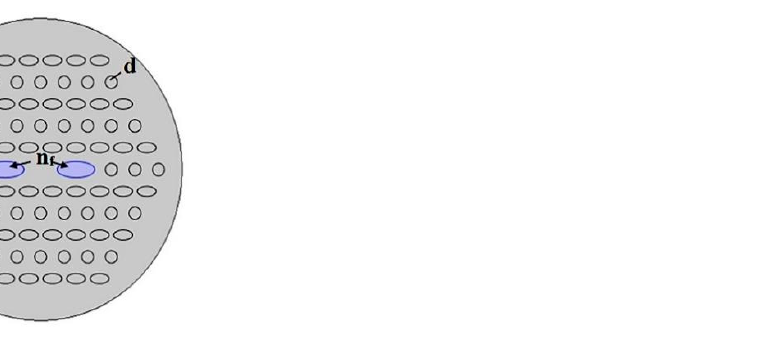
Figure 1. Cross-section of designed magnetic fluid-filled dual-core PCF magnetic field sensor.